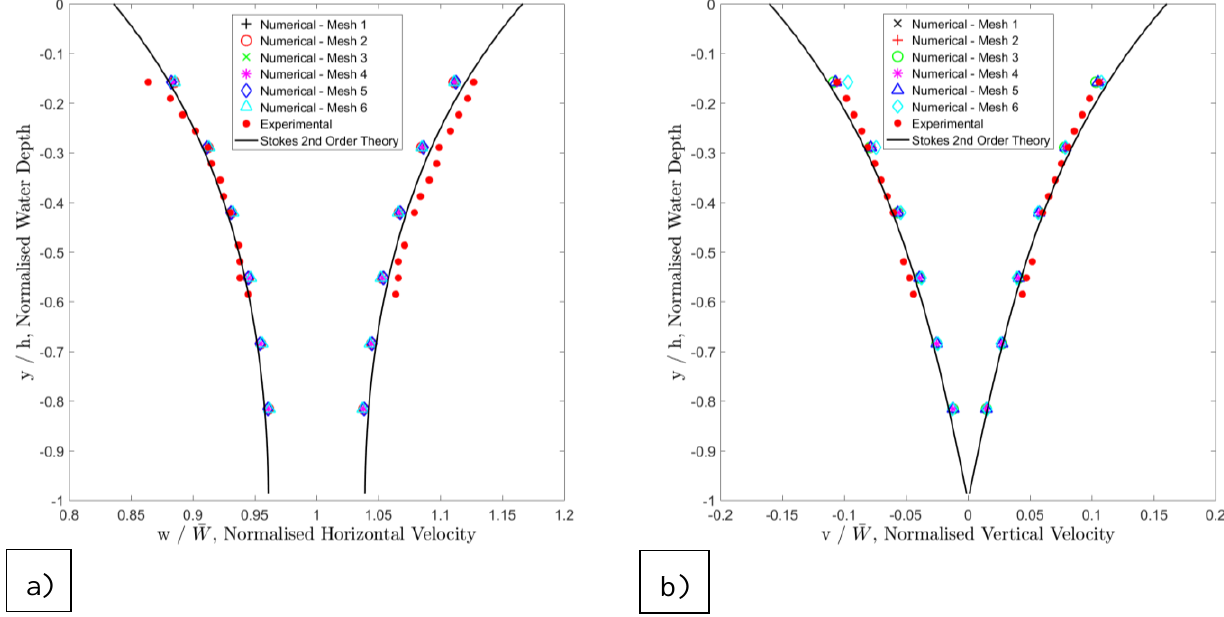
Figure 5. Normalised results for the numerical, theoretical and experimental maximum and minimum wave-induced: (a) horizontal and; (b) vertical velocities.